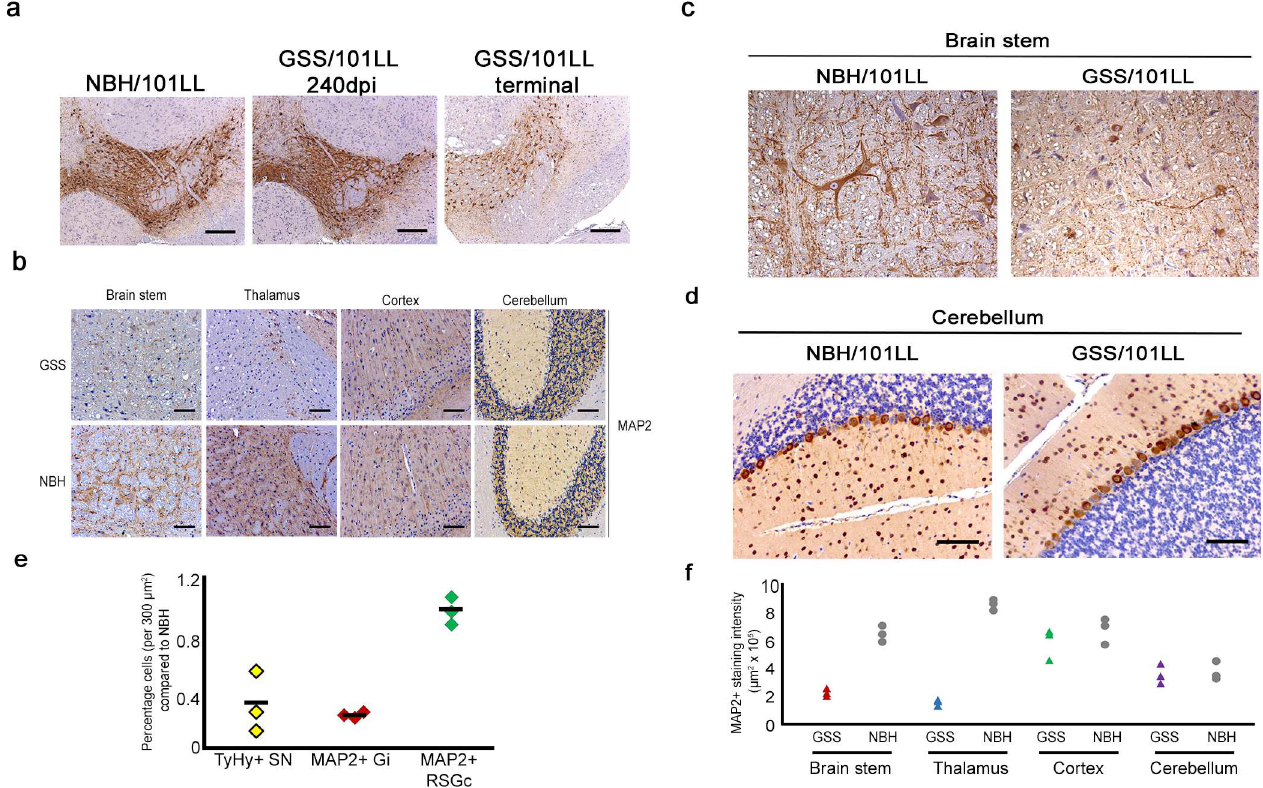
Fig 4. Changes in neuronal markersdemonstrate specific neuronal populations targeted to certain brain regions. (a) Tyrosine hydroxylasestainingof midbrainneurons.No visiblechange in stainingpattern could be observedin any GSS/101LL animal tested at 240 dpi ( n = 6) comparedto age- and region-matched NBH/101LLcontrols ( n = 6). A marked loss of staining pattern is observedin the midbrainneurons upon clinical onset (291.1 ± 5.3 dpi), indicativeof a loss of tyrosine hydroxylase neuronsupon clinicalonset of disease.Scale bar = 200 μ m. (b) MAP2 stainingin brain stem has marked loss of MAP2 cell–associated stainingcomparedto NBH/101LLbrain stem age-matched control. Overall, levels of MAP2 staining are visibly lost in the ventral-medial parts of the thalamuscomparedto region-and age-matched NBH/101LL controls. No change could be observed in the staining pattern of MAP2 in any part of the cortex or cerebellumcomparedto region-and age-matched NBH/ 101LL controls. These findings are observedconsistently across all animalstested; GSS/101LL ( n = 9), NBH/101LL ( n = 4). Scale bars = 100 μ m. (c) Higher magnification examplesof MAP2 neuronslost in the gigantoreticular nucleiof the brain stem but no loss of neuronsevidencedin the cortex. (d) Parvalbumin staining of Purkinjecells of the cerebellumat clinicalstages of diseasein GSS/101LL animals(291.1 ± 5.3 dpi; n = 3) comparedto age-matched NBH/101LLcontrols ( n = 3). Scale bars = 100 μ m. (e) Neuronal cell counts of substantianigra (SN) neuronsof the midbrain,gigantocellular reticular nuclei (Gi) of the brain stem, and retrosplenial granularregion(RSGc) of the cortex from three representative animals. Cells countedbasedupon the number of cells showingpositive stainingfor either tyrosine hydroxylase (TyHy+) in the SN or MAP2 in the Gi and RSGc. (f) Quantification of MAP2+ staining intensity from three representative animalsshowinga loss of MAP2 staining in brain stem and the thalamusbut no changein the cortex or cerebellum. Quantification of stainingwas performed using colourdeconvolution plug-inof Image-J